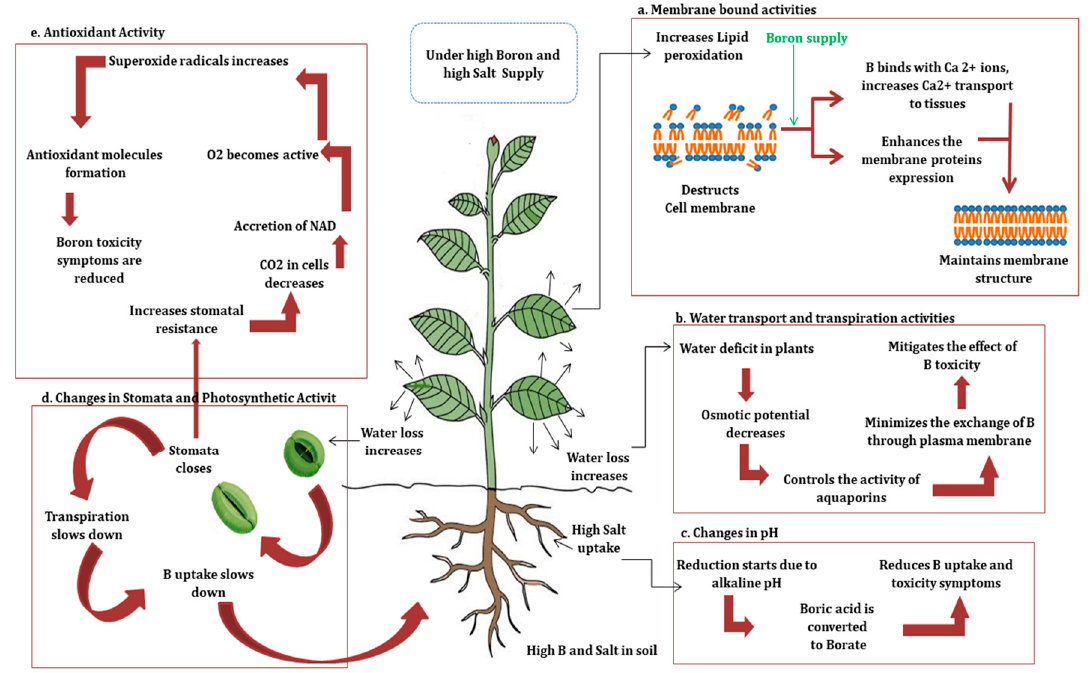
Figure 2. An insight into the mitigating effect of combined high B and salt stress on the toxicity symptoms in plants. Toxicity symptoms are reduced via different pathways/strategies involved. ( a ) Membrane bound activities, ( b ) water transport and transpiration activity, ( c ) changes in pH, ( d ) changes in stomatal and photosynthetic activity, and ( e ) antioxidant activity.